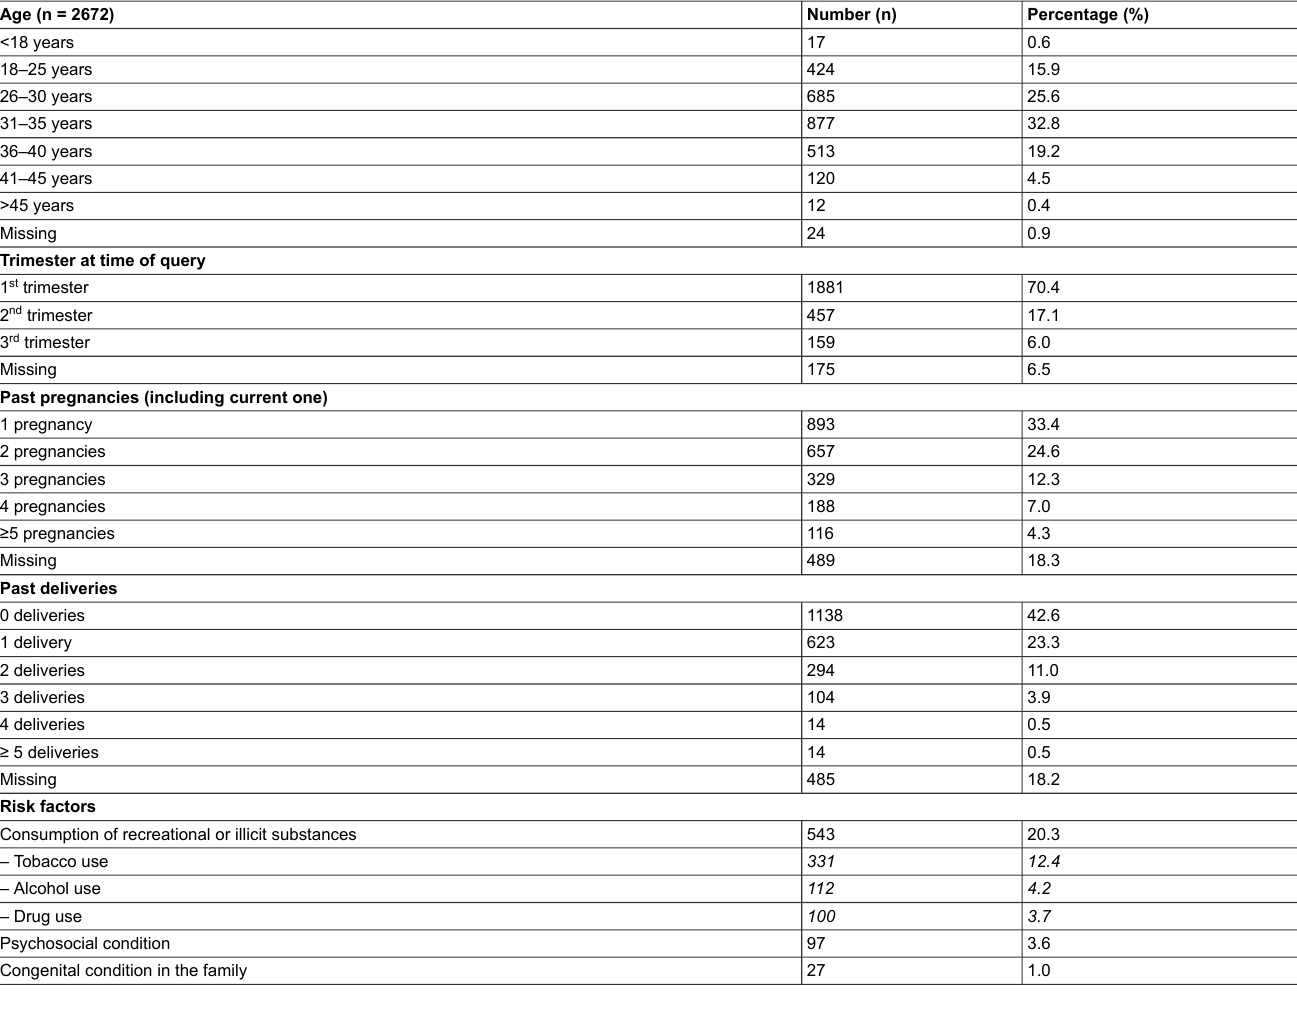
Table 2: Health-related characteristics of mothers with exposure to at least one medication during a singleton pregnancy with available follow-up data. Age (n =